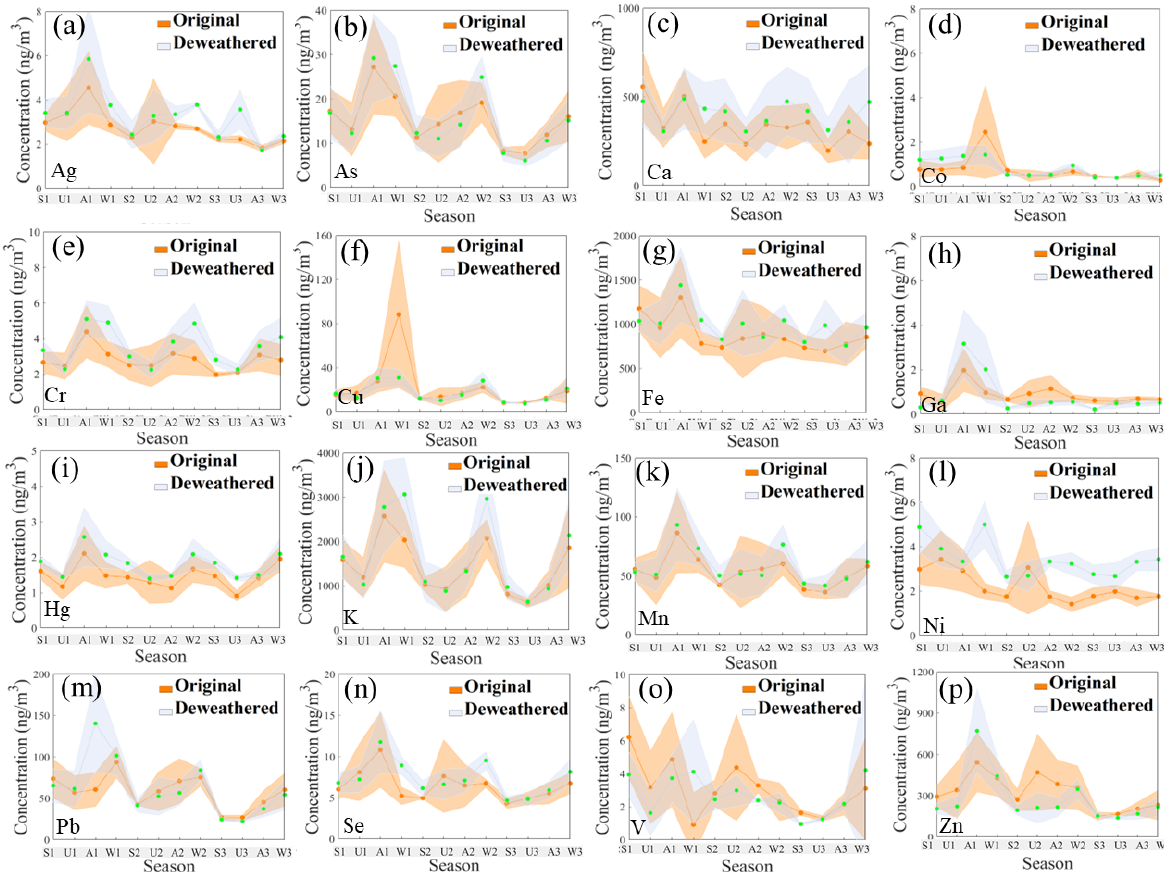
Figure 4. Original (red and orange) and deweathered (green and blue) element concentrations (ngm − 3 ) in PM 2 . 5 in Tangshan in four seasons S2, U2, A2, and W2 denote the spring, summer, autumn, and winter during 2018–2019. S3, U3, A3, and W3 are the spring, summer, autumn, and winter during 2019–2020. The points and shaded areas represent mean values and associated standard deviations,